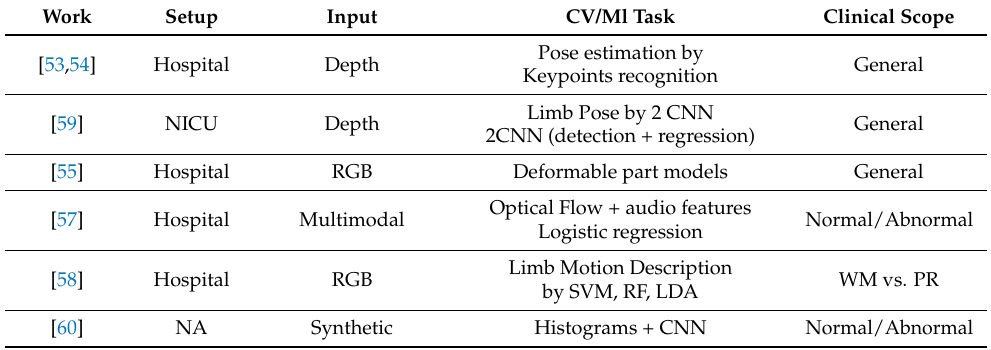
Figure 4. 1D convolutional neural network architecture exploited in [60] for labelling observed movements as indicative of typically developing infants (Normal) or that may be of concern to clinicians (Abnormal). Table 2. Summarization of works dealing with movements assessment in